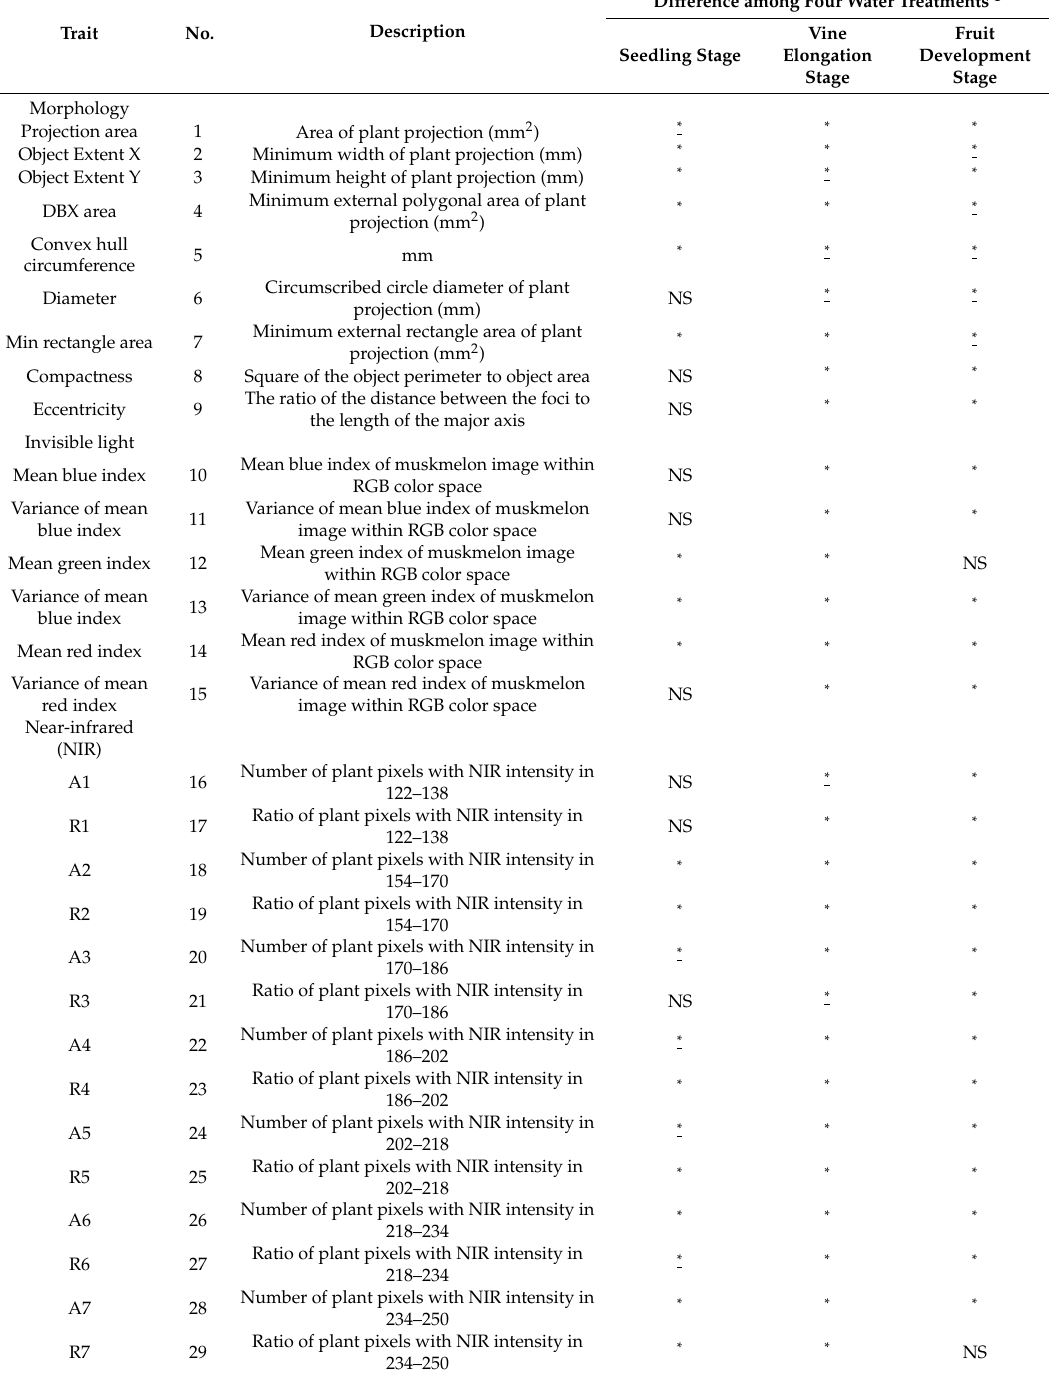
Table 1. Phenotypic traits extracted from collected images of muskmelon.